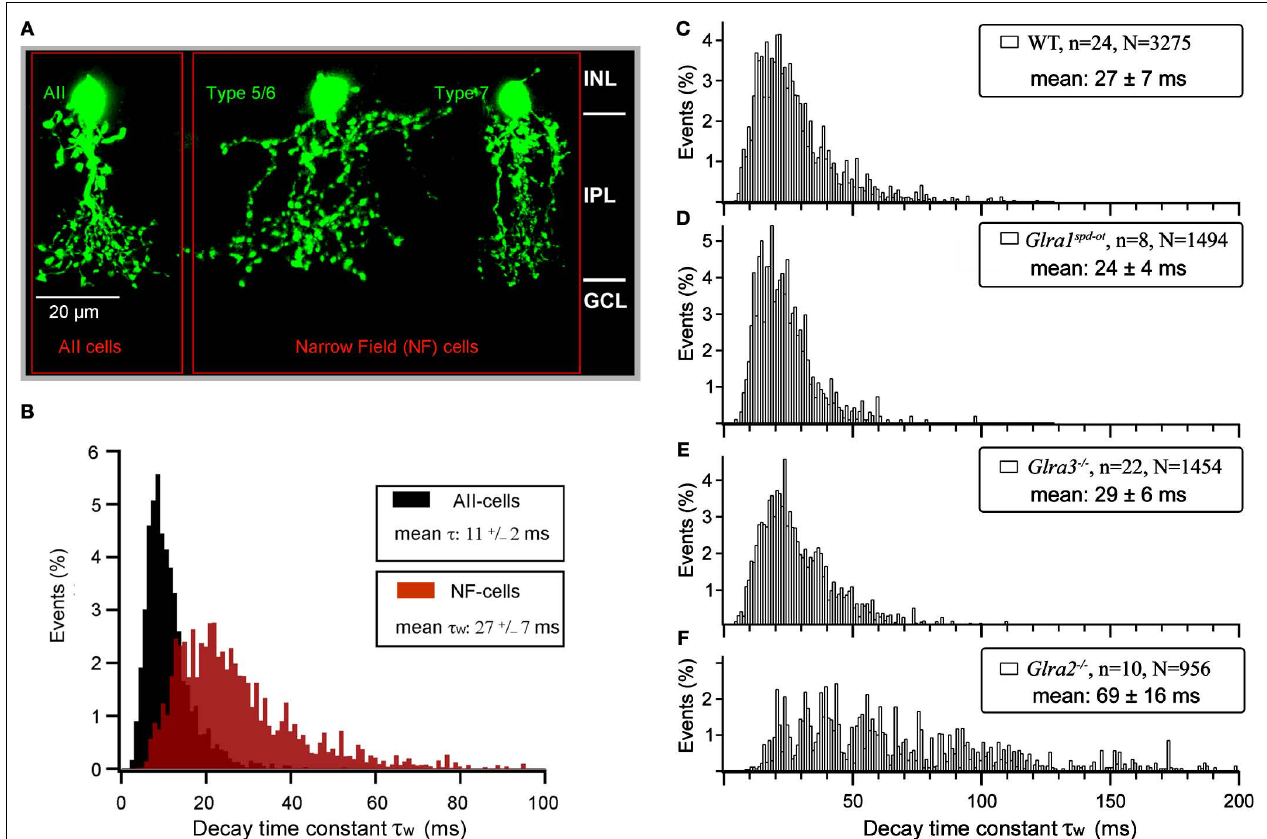
FIGURE 7 | Glycinergic sIPSCs of small-fi eld amacrine cells of the mouse retina (modifi ed from Weiss et al., 2008). (A) Collapsed stack of confocal sections through an AII amacrine cell (left), a Type 5/6 cell (center) and a Type 7 cell (right). They are referred to as narrow-fi eld (NF) amacrine cells. (B) Frequency histogram of decay time constants of glycinergic sIPSCs recorded from AII cells